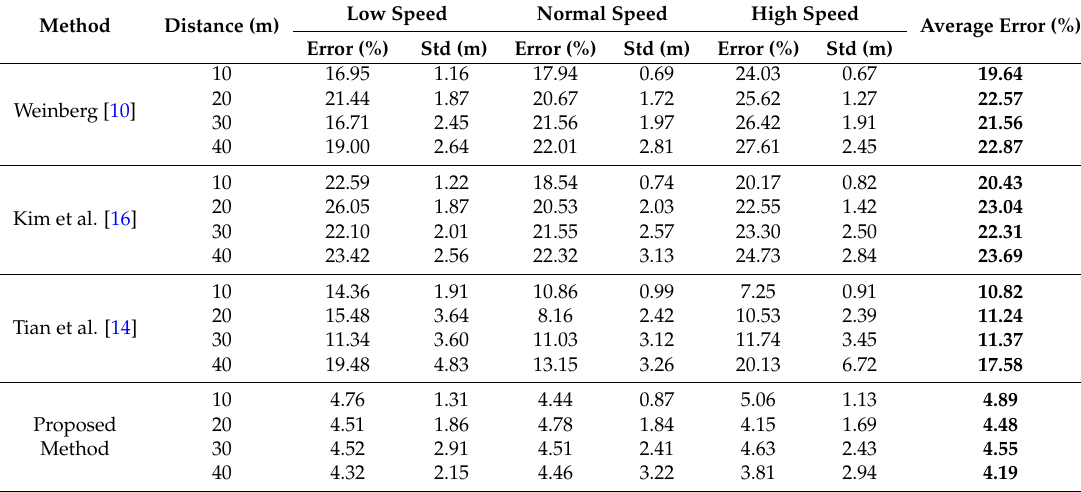
Table 2. Estimation errors and standard deviations of walking distance